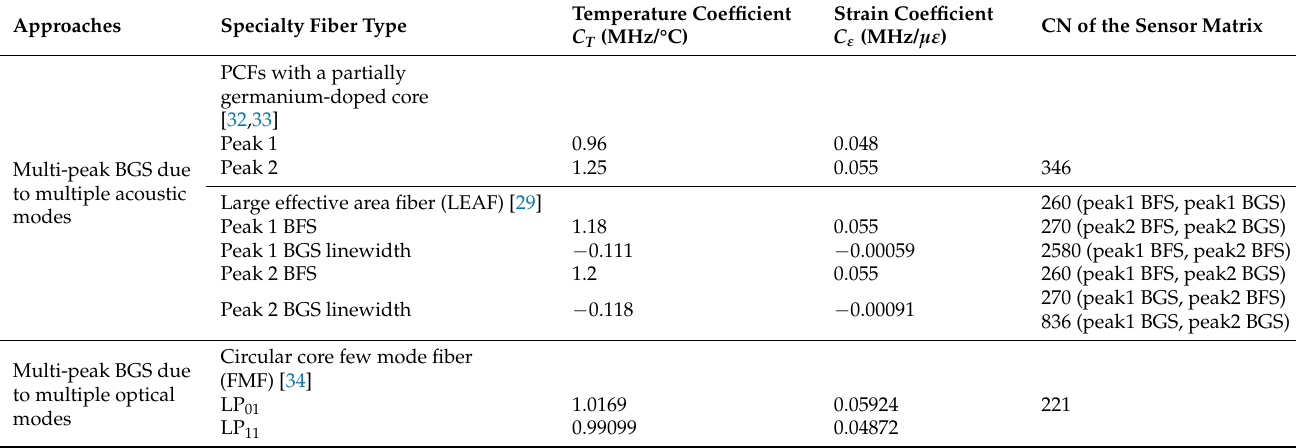
Table 1. Summary of reported approaches to achieve discriminative sensing using specialty